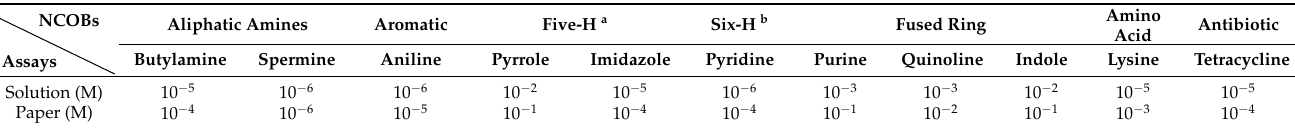
Table 1. Sensitivities of solution and test paper assays developed from C-dots for the detection of various NCOBs. AssaysNCOBs Aliphatic